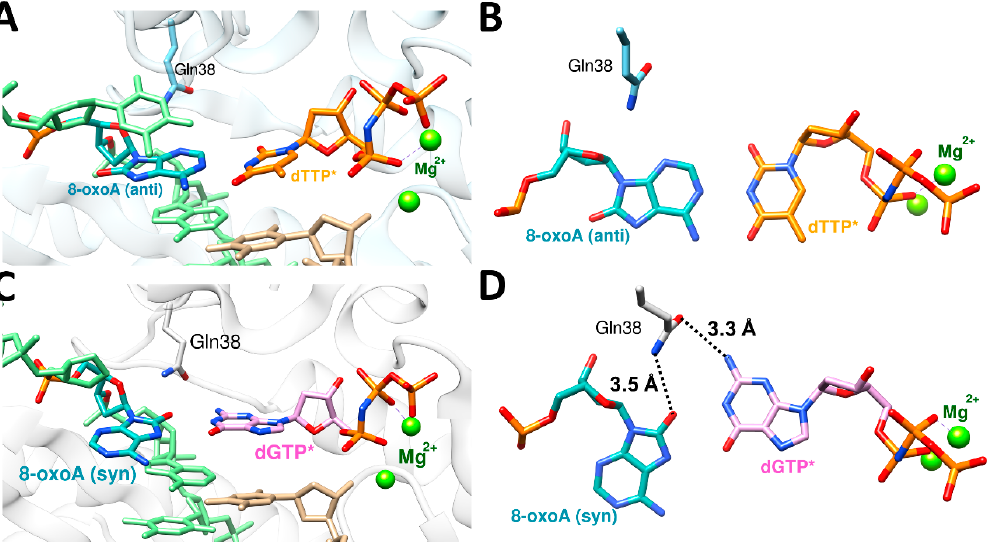
Figure 5. The active site structures of pol η complexed with 8-oxoA and the incoming nucleotides, dTTP (PDB ID: 6PL8) and dGTP (PDB ID: 6PLC). ( A ) 8-oxoA (anti) and the incoming dTTP* in the active site of pol η with catalytic Mg 2+ , primer, template, and Gln38 shown. ( B ) The canonical base pair between 8-oxoA(anti) and dTTP* with no additional interaction with Gln38. ( C ) 8-oxoA (syn) and the incoming dGTP* in the active site of pol η with catalytic Mg 2+ , primer, template, and Gln38 shown. The primer terminus shows two alternative conformations. ( D ) Non-canonical base pair be- tween 8-oxoA (syn) and dGTP*, and this base pair is further stabilized by the hydrogen bonding interaction with Gln38.